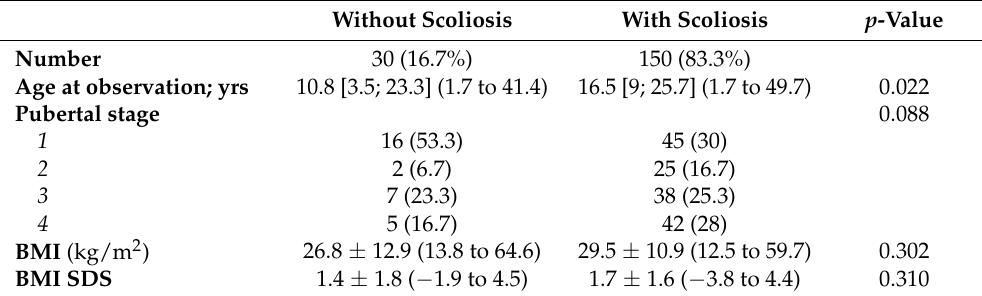
Table 3. Clinical and anthropometric measurements of PWS patients at final evaluation according to scoliosis.